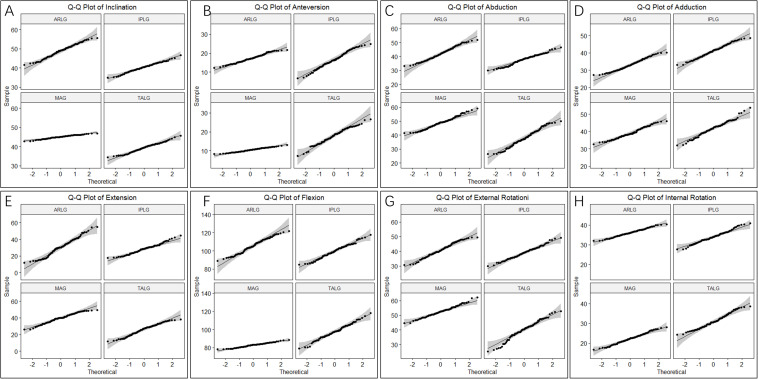
Q-Q plot of cup orientation and hip ranges of motion (HROMs). Two parameters of cup positioning, inclination (A) and anteversion (B), and six parameters of HROMs, abduction (C), adduction (D), extension (E), flexion (F), internal rotation (G), and external rotation (H), were normally distributed.